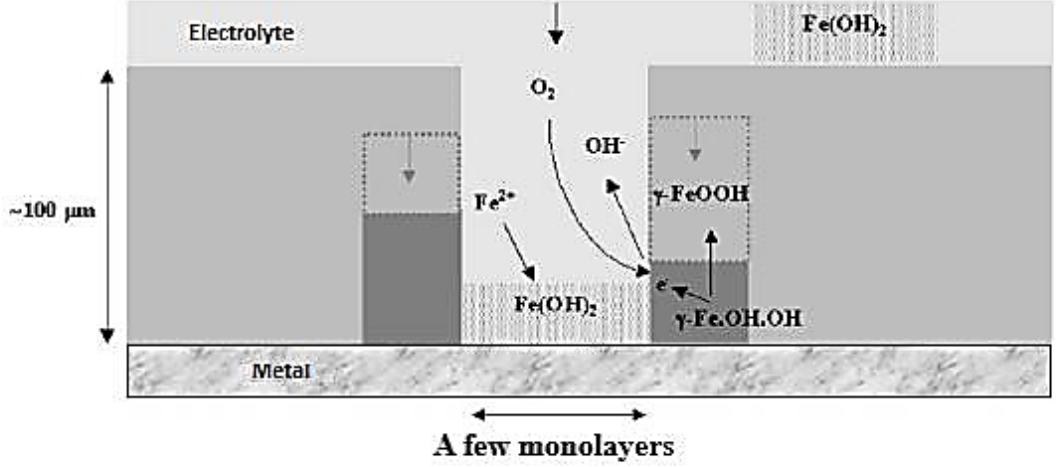
Figure 7. Representation of the phenomena involved in the drying process.